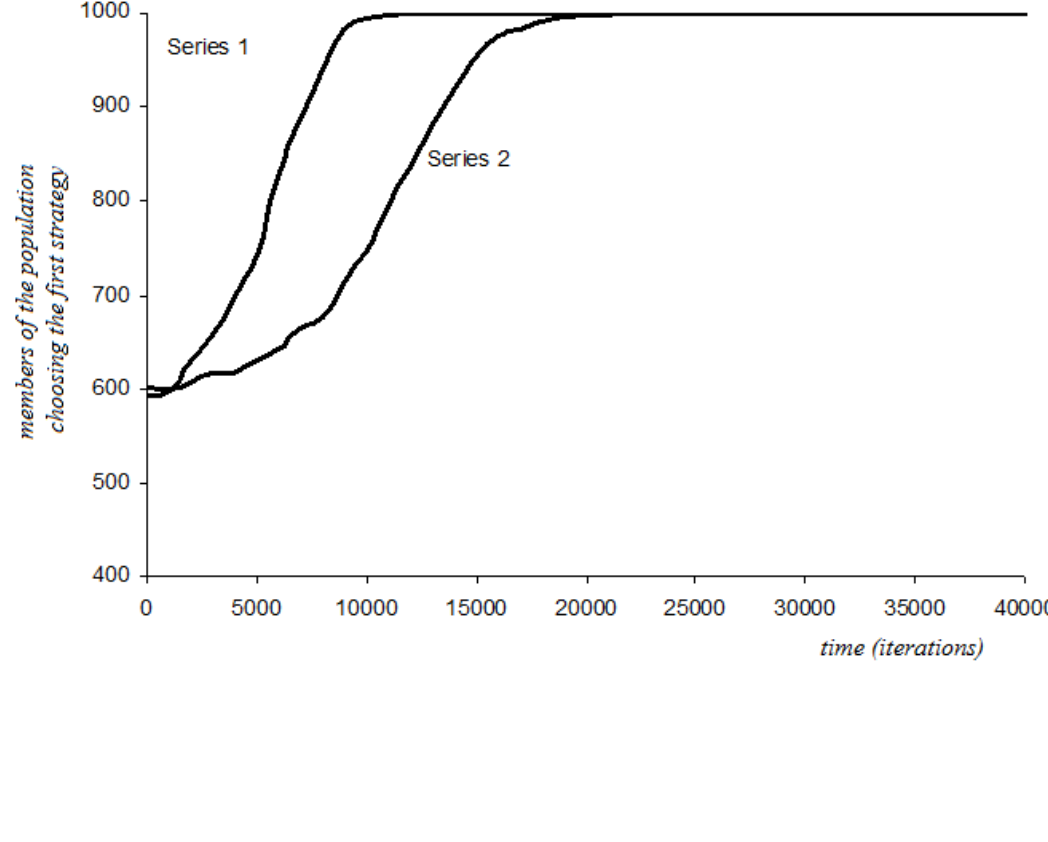
= 0.6. Series 1: a = 0. Series 2: a = 0.1, b = 0